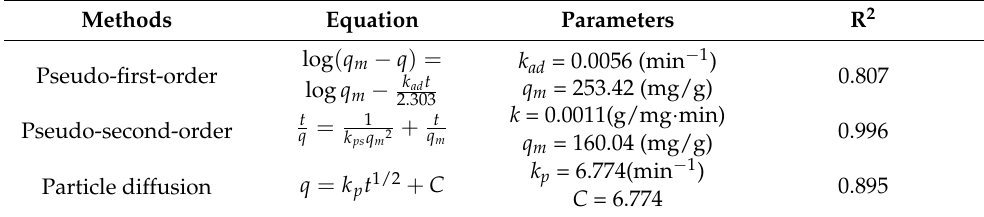
Table 4. Adsorption kinetic parameters of Fe(III) onto